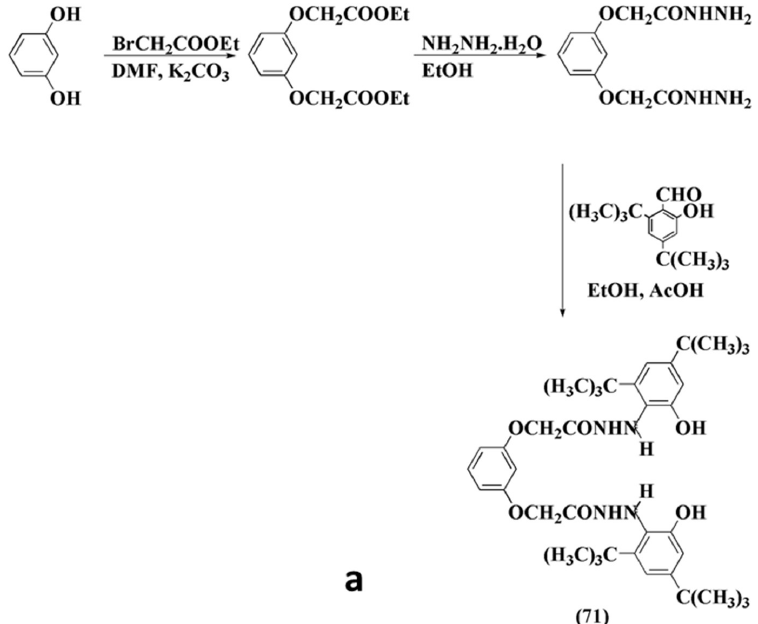
Table 5. DPPH scavenging ability (IC 50 , mg/mL) of the reference (ascorbic acid) and the metal-PLY chelates [151].